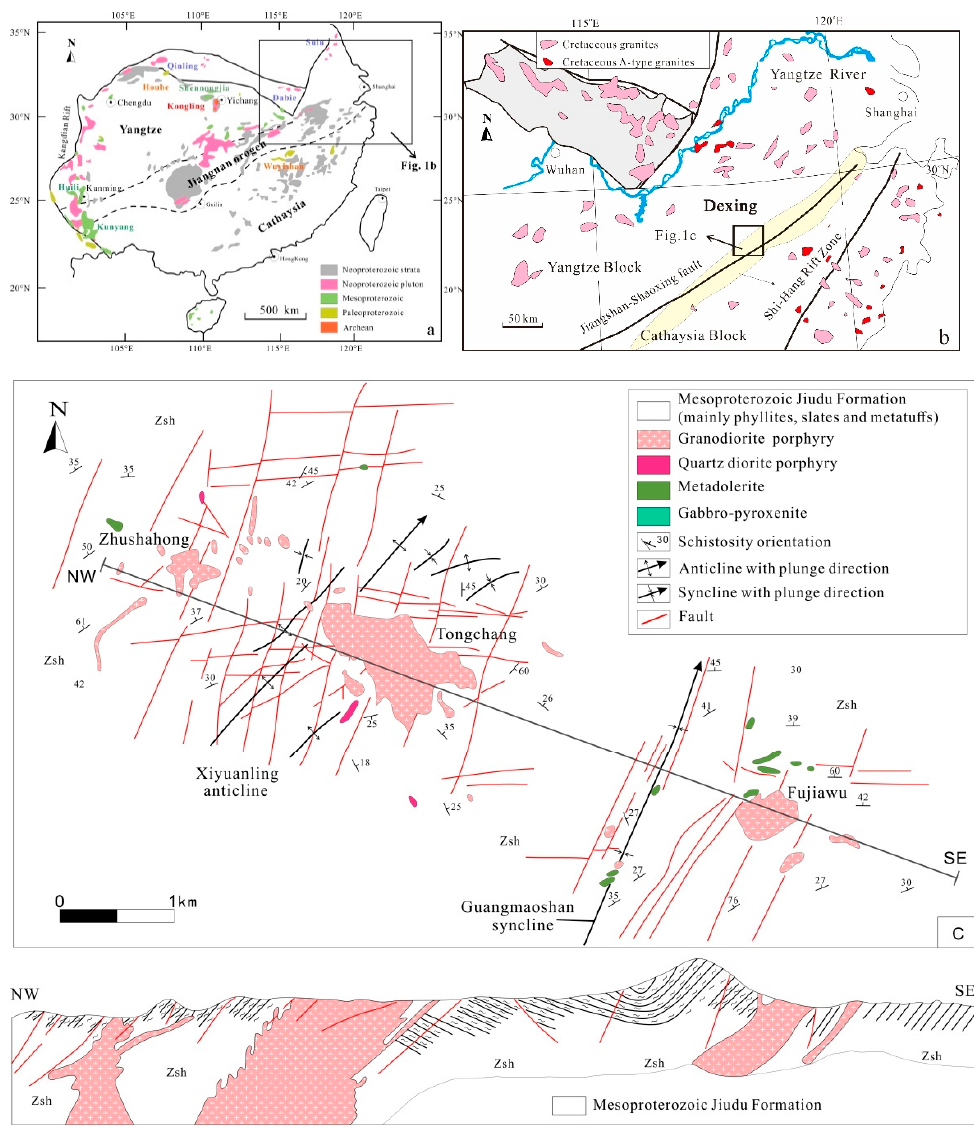
Figure 1. ( a ) Simplified geologic map of the South China Craton (after Zheng et al. [52]), showing the distribution of Precambrian rocks containing the Shuangqiaoshan Group; ( b ) geologic map of southeast China, showing the main granitic porphyries and location of the Dexing porphyry Cu (-Mo-Au) district; ( c ) geologic map and longitudinal section from the Dexing deposit (after Yang et al. [53]).